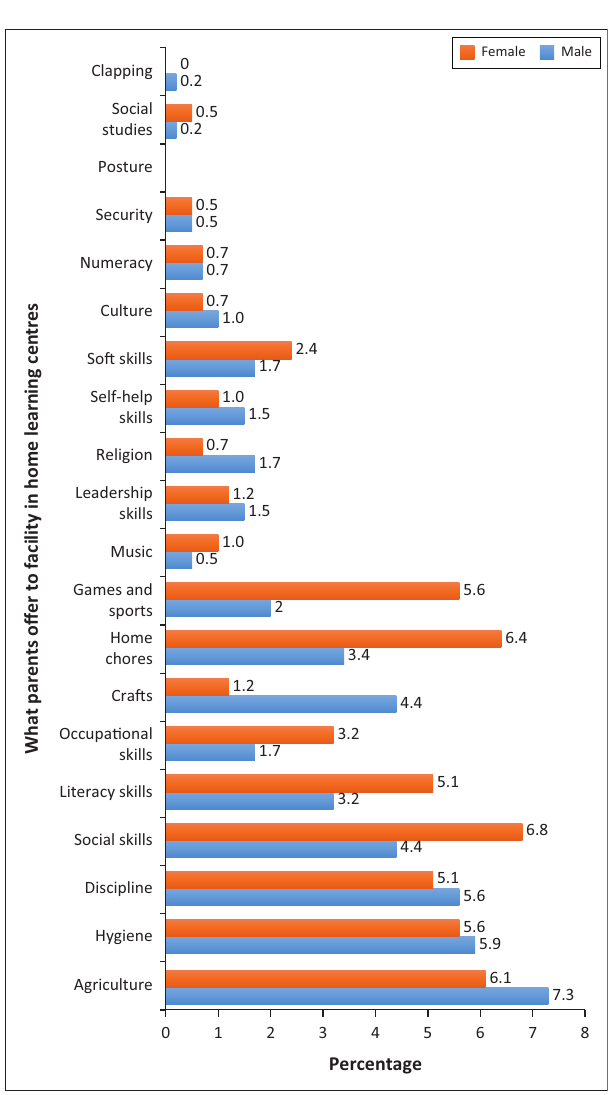
FIGURE 3: What the participants can teach in HBECD given by